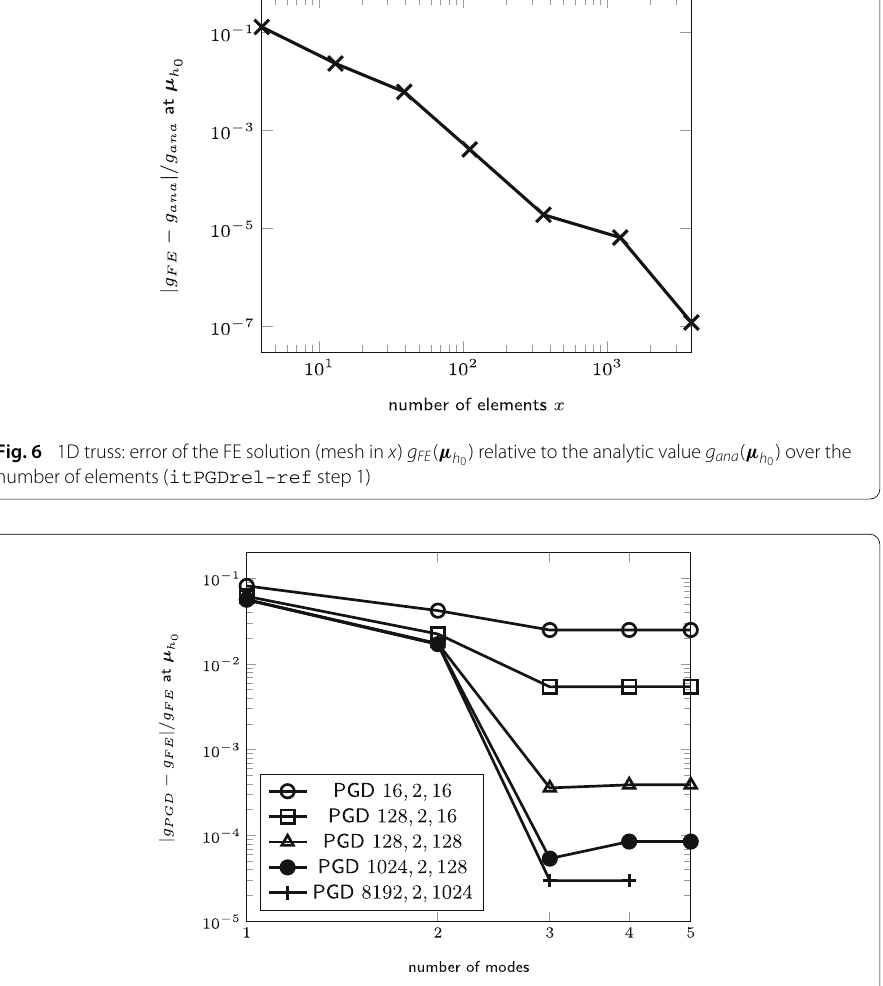
Fig. 7 1D truss: error of PGD limit state function at the first design point approximation μ h of PGD modes M and different PGD mesh discretization ( itPGDrel-ref step 2 and 3). The number of linear elements in (cid:12) , λ , E is given in the legend (in x 361 linear